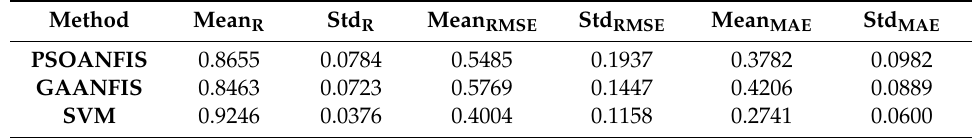
Figure 8. Statistical results over 774 Monte Carlo simulations using the PSOANFIS, GAANFIS and SVM for I C in case of: ( a ) R; ( c ) RMSE and ( e ) MAE along with the probability density distribution of ( b ) R, ( d ) RMSE and ( f ) MAE. Table 6. The robustness of PSOANFIS, GAANFIS and SVM for testing